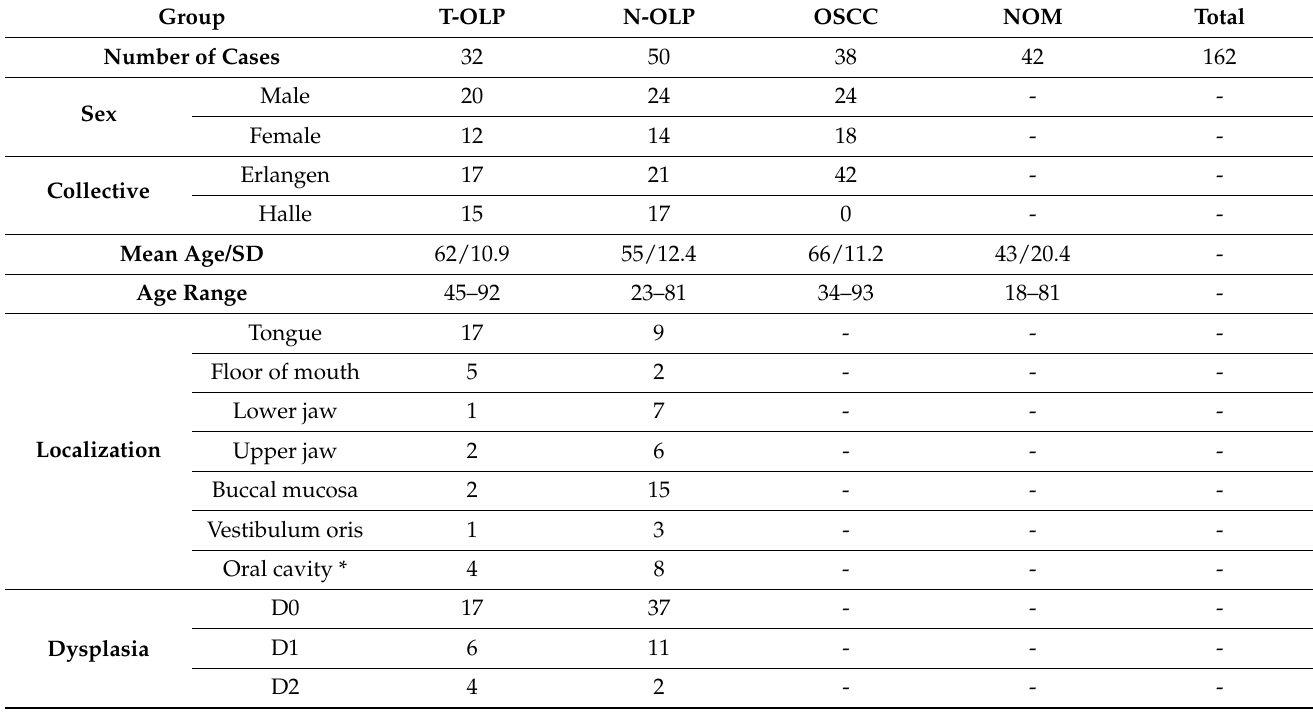
Table 1. Demographic, clinical and histopathological characteristics of the histological patients’ collective used in RT qPCR. Group